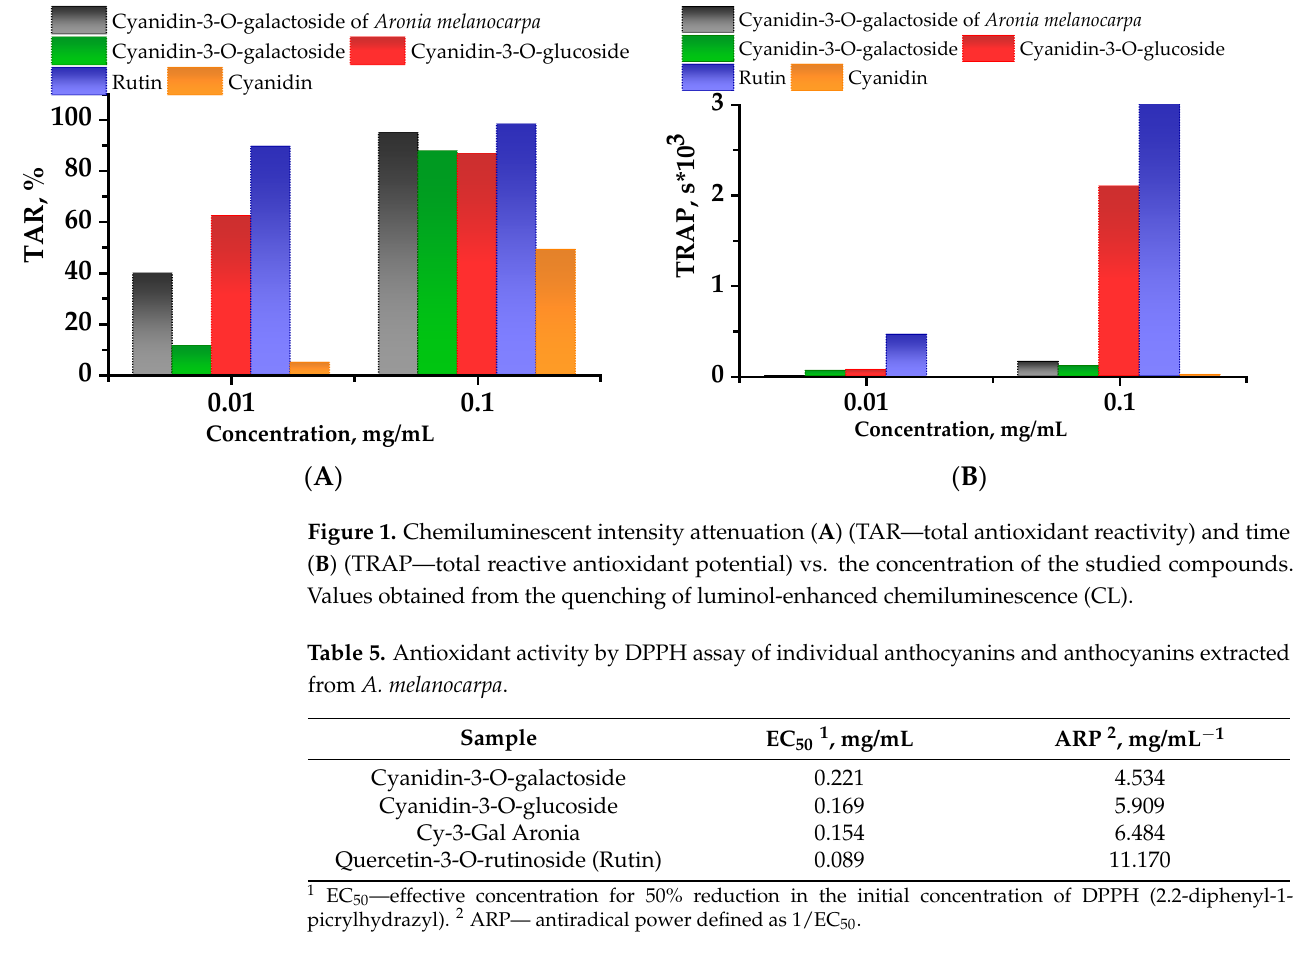
Table 5. Antioxidant activity by DPPH assay of individual anthocyanins and anthocyanins ex- tracted from A. melanocarpa .